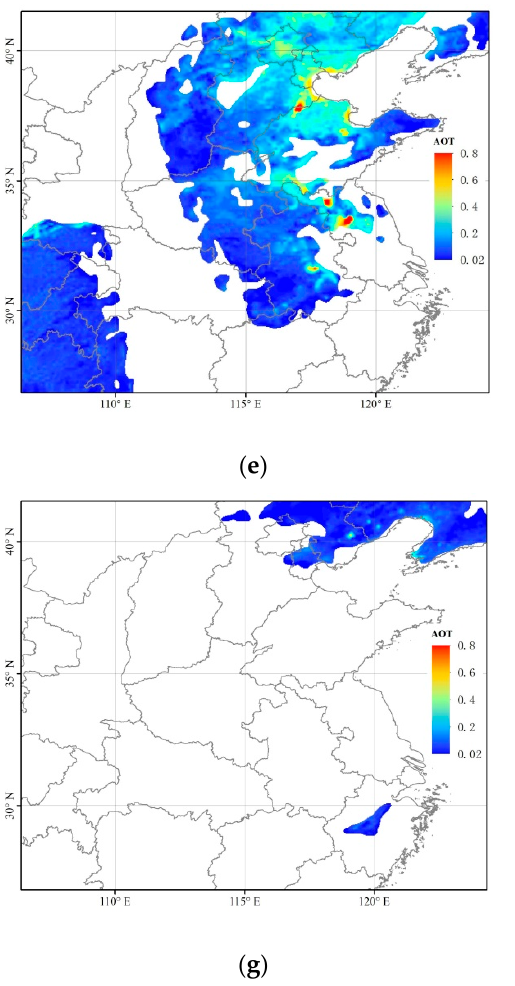
Figure 3. The fine-mode AOD retrieved from DPC over north China from ( a ) 30 October to ( f ) 5